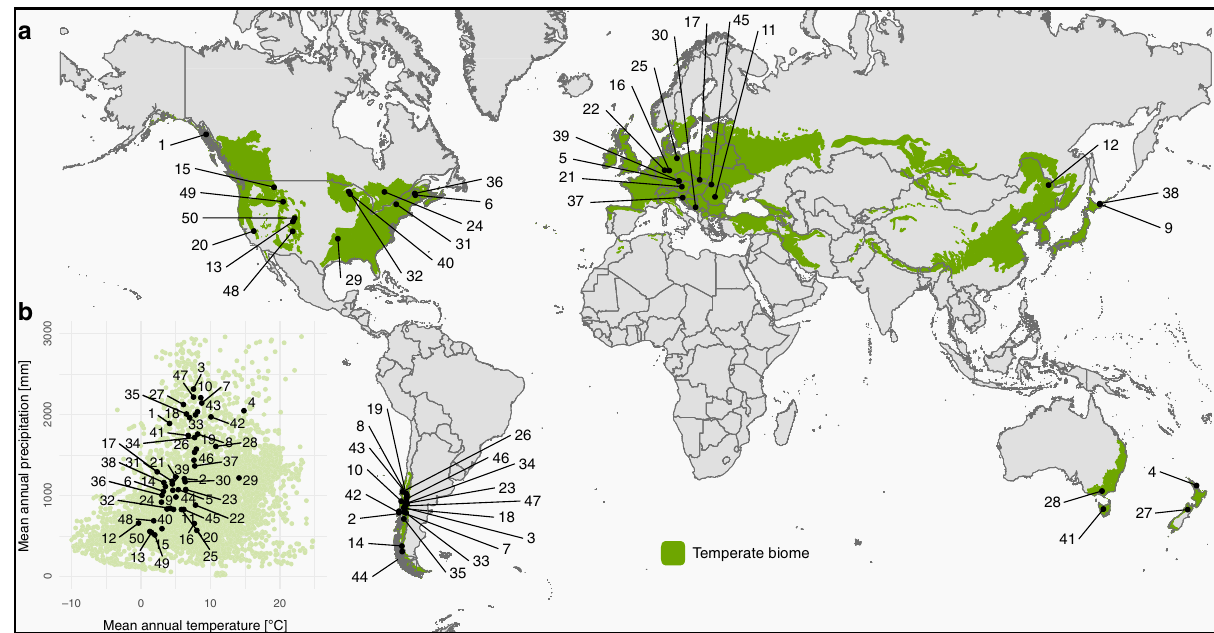
Fig. 1 A network of 50 protected landscapes to understand global patterns and drivers of temperate forest disturbances. a The geographic location of the landscapes, and b their location in climate space. The area of the temperate biome is indicated in green 47 . See Supplementary Table 1 for more detailed information on the individual landscapes. Note that the climatic envelope of the biome (green dots in b ) is based on a sample of 10,000 4500 m×4500 m grid cells throughout the